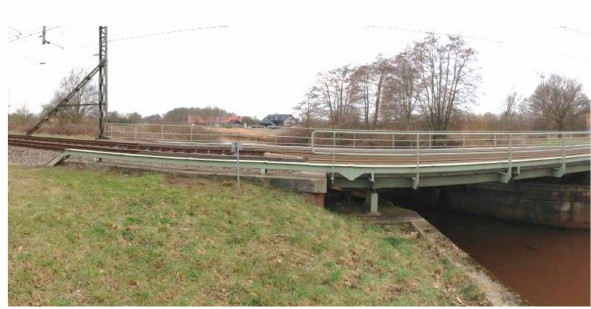
Figure 1. A typical bridge transition